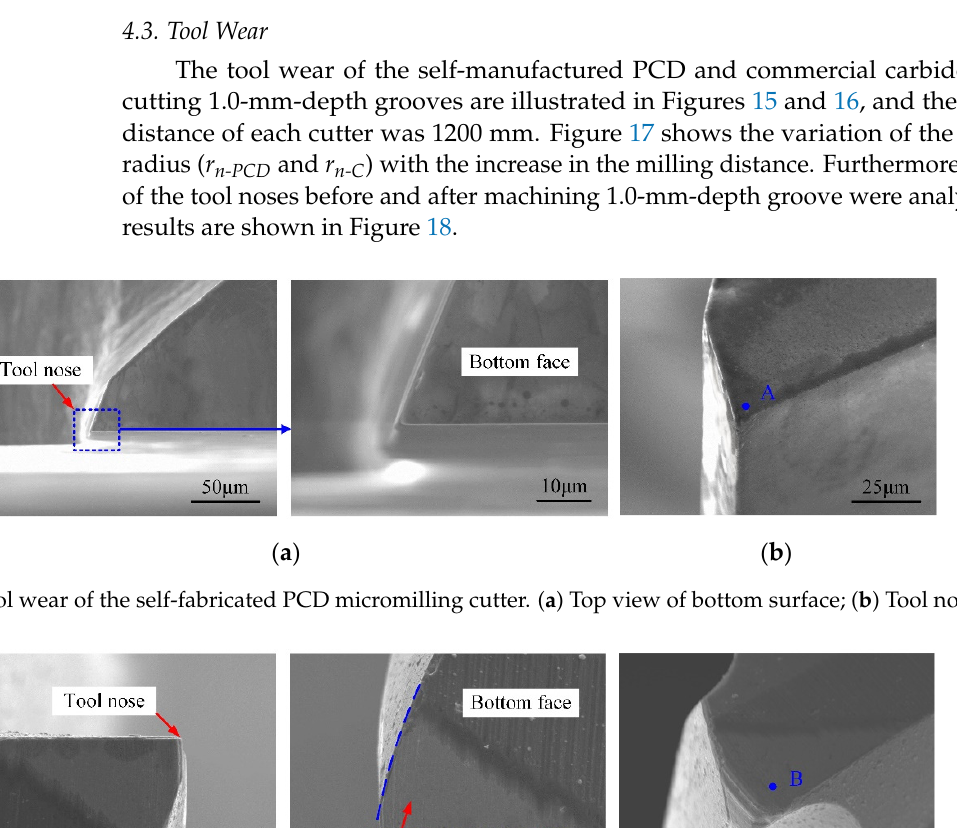
Figure 14. Variation of the bottom widths ( w b ) with the milling distance.